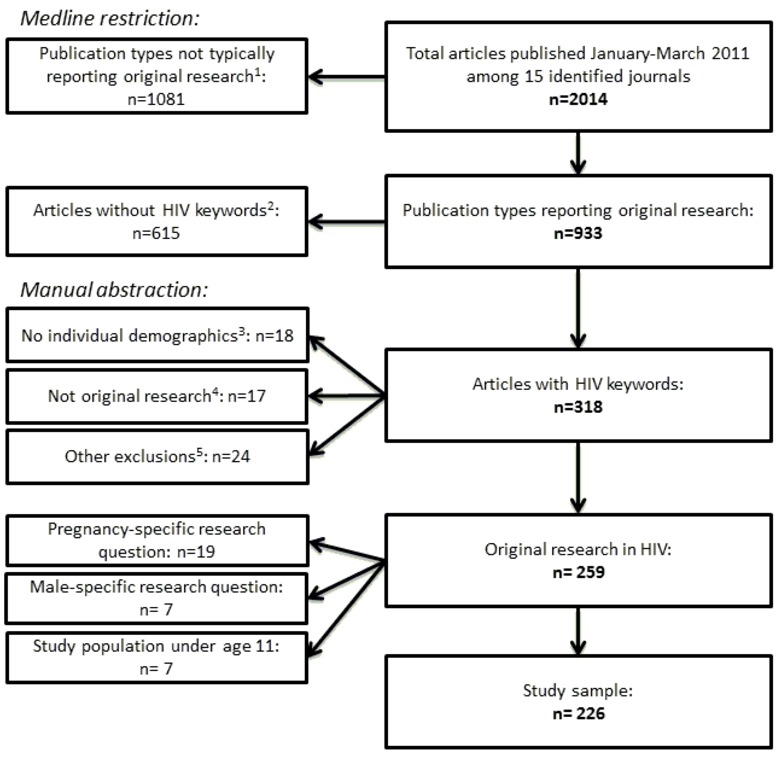
Flowchart of included studies.
1Historical articles, news, editorials, letters, comments, case reports, reviews, patient education handouts, meta-analyses. 2Keywords: HIV, AIDS, anti-retrovir*, antiretrovir*, retrovir*, human immunodeficiency virus. 3Ecological studies, surveillance studies, animal studies, modeling studies. 4Commentary, reviews, invited articles. 5Other retroviruses, studies of non-HIV related outcomes in HIV-negative populations, study of clinicians/service providers, studies in non-human subjects, blood donation screening study.